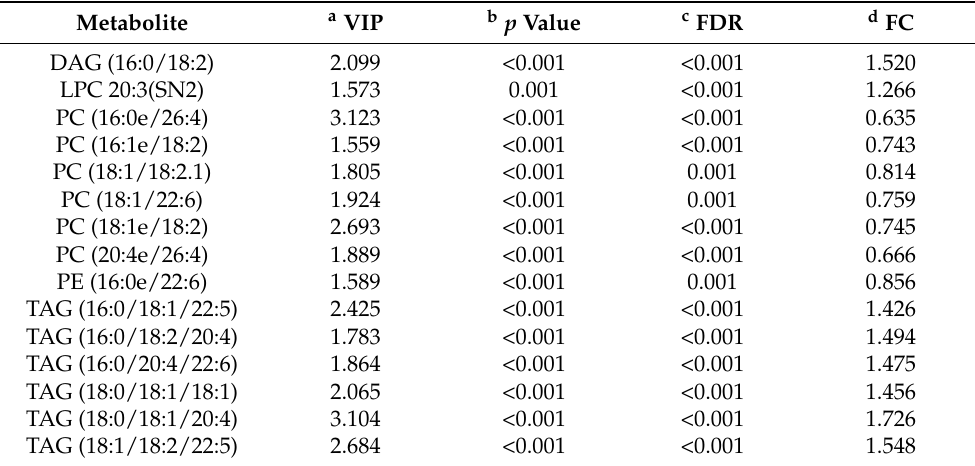
Table 2. Identified differential lipid metabolites between the AS and HCs.